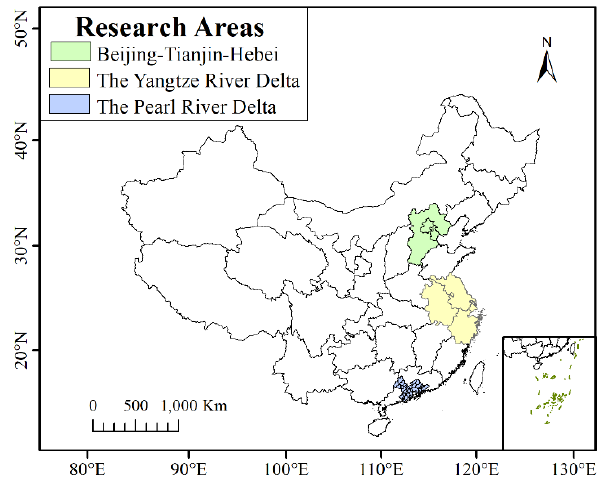
Figure 1. The China map with three typical pollution regions investigated in this study, which are the Beijing-Tianjin-Hebei (BTH), the Yangtze River Delta (YRD), and the Pearl River Delta (PRD)